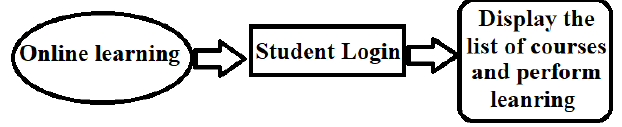
Figure 8. Layered architecture to achieve the